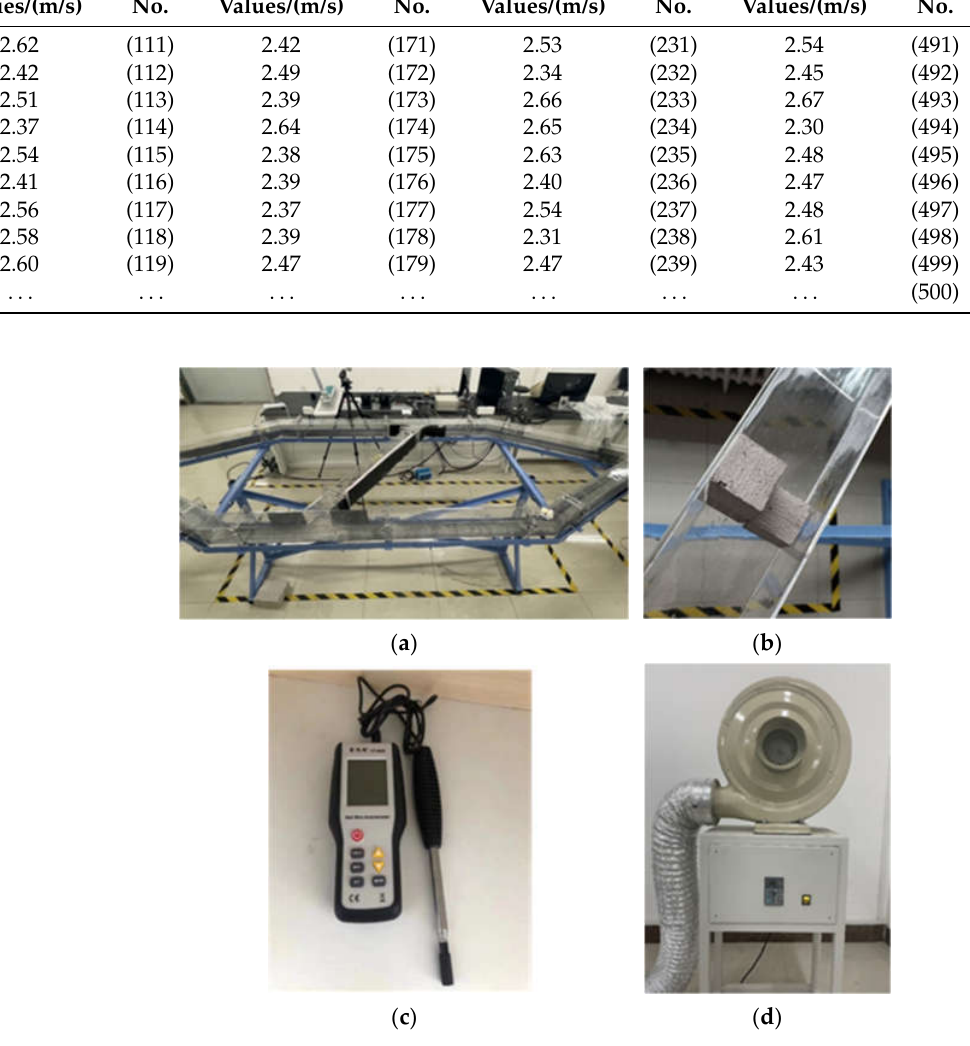
Figure 2. Diagram of the experimental equipment: ( a ) Simulated mine roadway; ( b ) Obstacles in the roadway; ( c ) Thermal anemometer; ( d ) Variable frequency fan. Table 1. Monitoring wind speed sensor data in a certain period in coal mines.